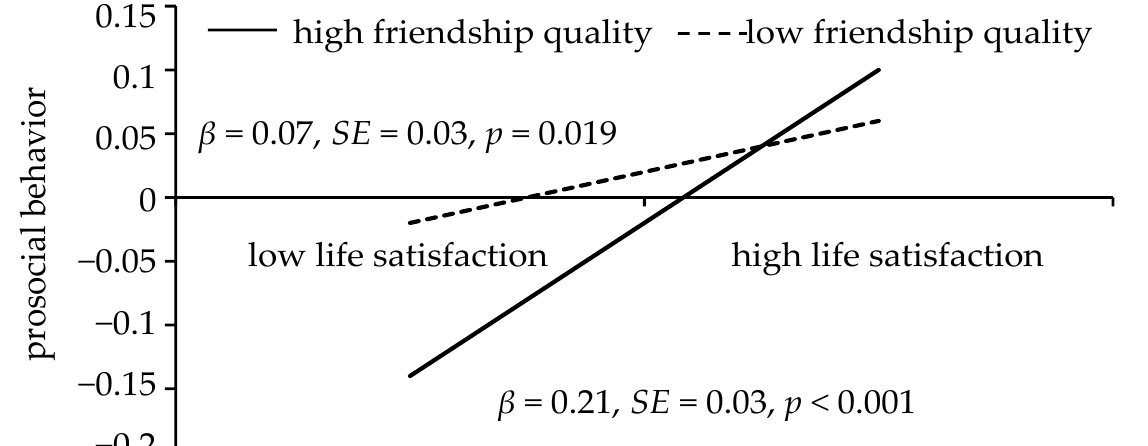
Figure 4. The prosocial behavior among students as a function of life satisfaction and friendship quality.